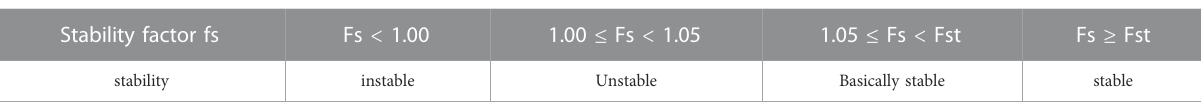
TABLE 3 Classi fi cation of landslide